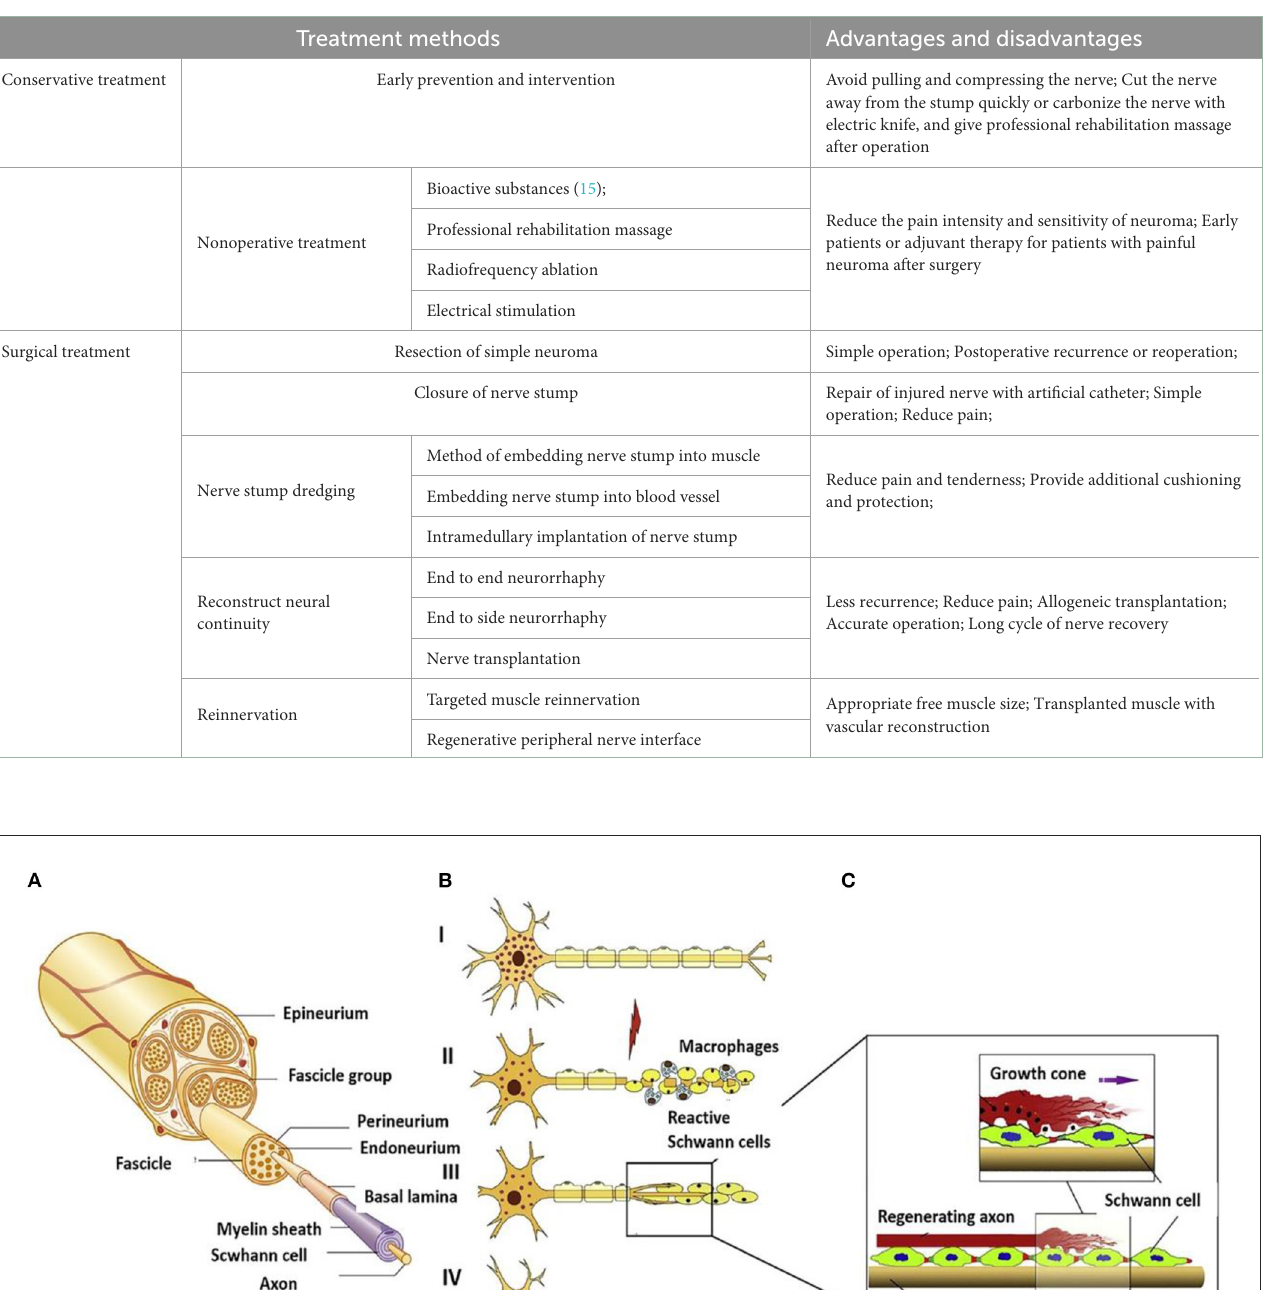
TABLE 1 Two different clinical treatments for